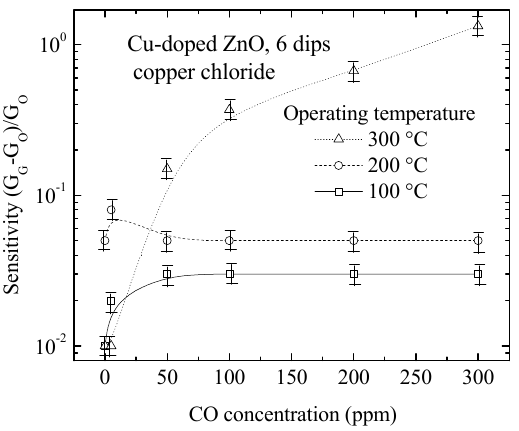
Figure 10. Sensitivity as a function of CO concentration at different operation temperatures for Cu ‐ doped ZnO films prepared from six dips in copper chloride.